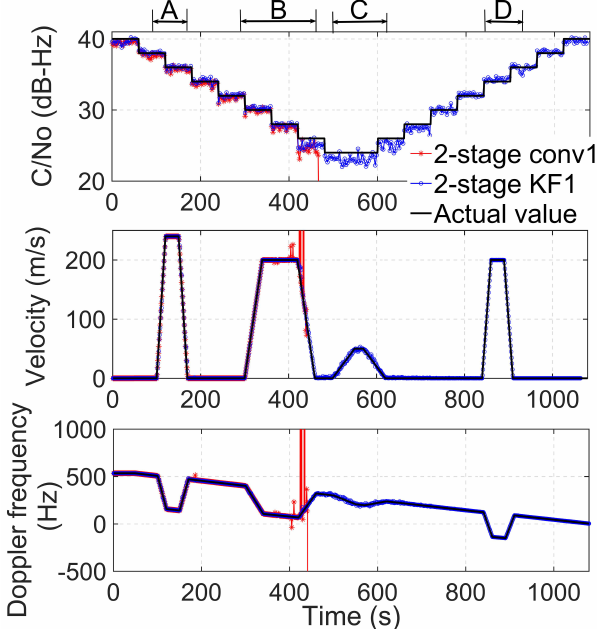
Figure 9. Tracking results for PRN 19 satellite signals under the dynamic weak signal condition. Top: C/ N 0 estimates. Middle: velocity estimates. Bottom: Doppler frequency